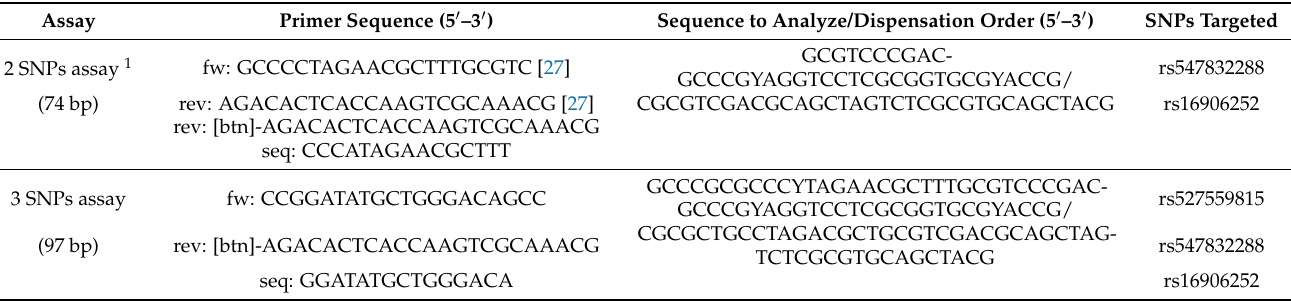
Table 1. Primer sequences and PCR-HRM-PSQ assay